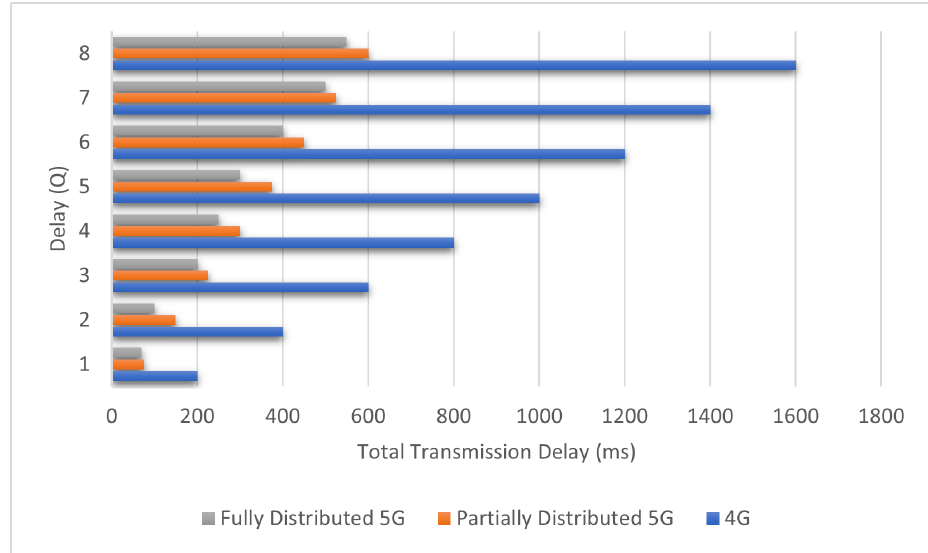
Figure 10. The impact of the queuing delay (Q) at each node.